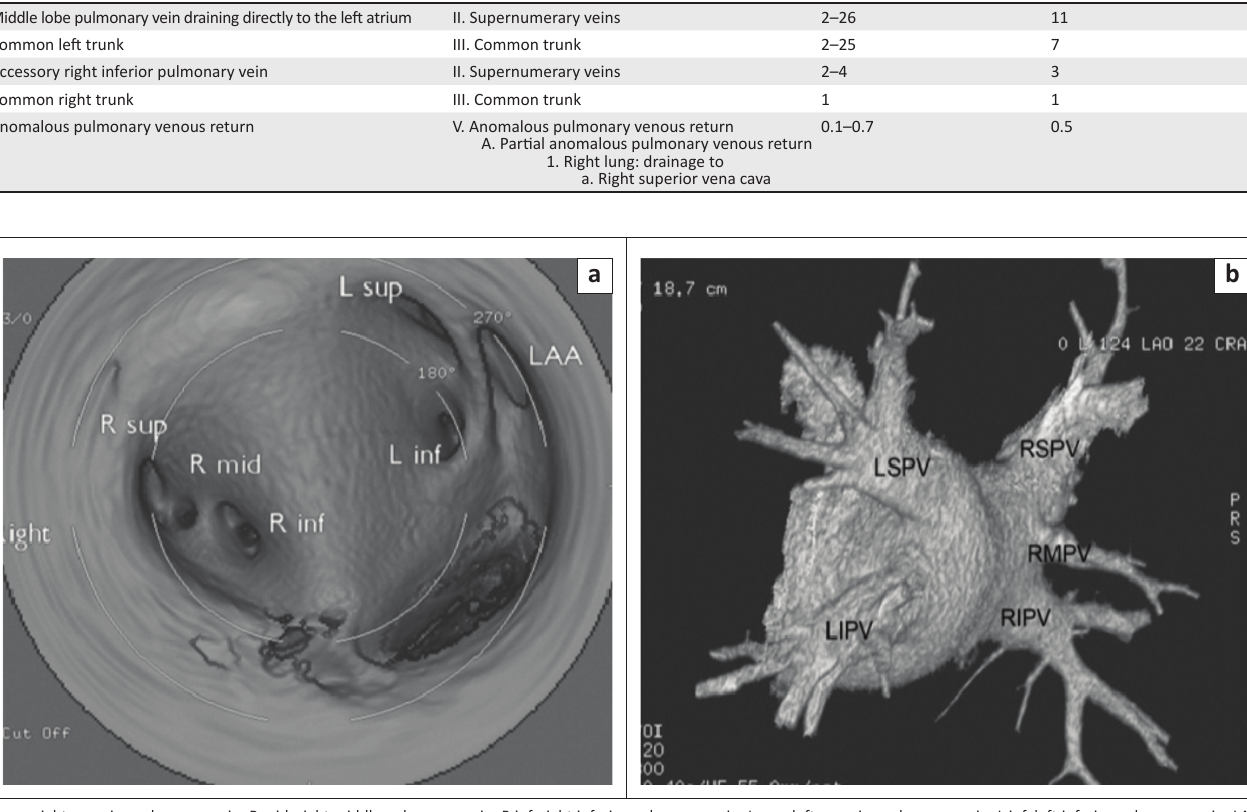
R sup, right superior pulmonary vein; R mid, right middle pulmonary vein; R inf, right inferior pulmonary vein; L sup, left superior pulmonary vein; L inf, left inferior pulmonary vein; LAA, left atrial appendage; RSPV, right superior pulmonary vein; RMPV, right middle pulmonary vein; RIPV, right inferior pulmonary vein; LSPV, left superior pulmonary vein; LIPV, left inferior pulmonary vein. FIGURE 2: Supernumerary veins in a 55-year-old man with atrial fibrillation. The middle lobe pulmonary vein has direct drainage into the left atrium: (a) The whole left atrial endocardial view with the right superior pulmonary vein ostium (R sup), right middle pulmonary vein draining directly in to the left atrium (R mid), right inferior pulmonary vein (R inf), left superior pulmonary vein (L sup), left inferior pulmonary vein (L inf) and left atrial appendage (LAA); (b) Three-dimensional model of the left atrium and pulmonary veins which shows the right superior pulmonary vein ostium (RSPV), middle lobe pulmonary vein ostium (RMPV), right inferior pulmonary vein ostium (RIPV), left superior pulmonary vein ostium (LSPV) and left inferior pulmonary vein ostium